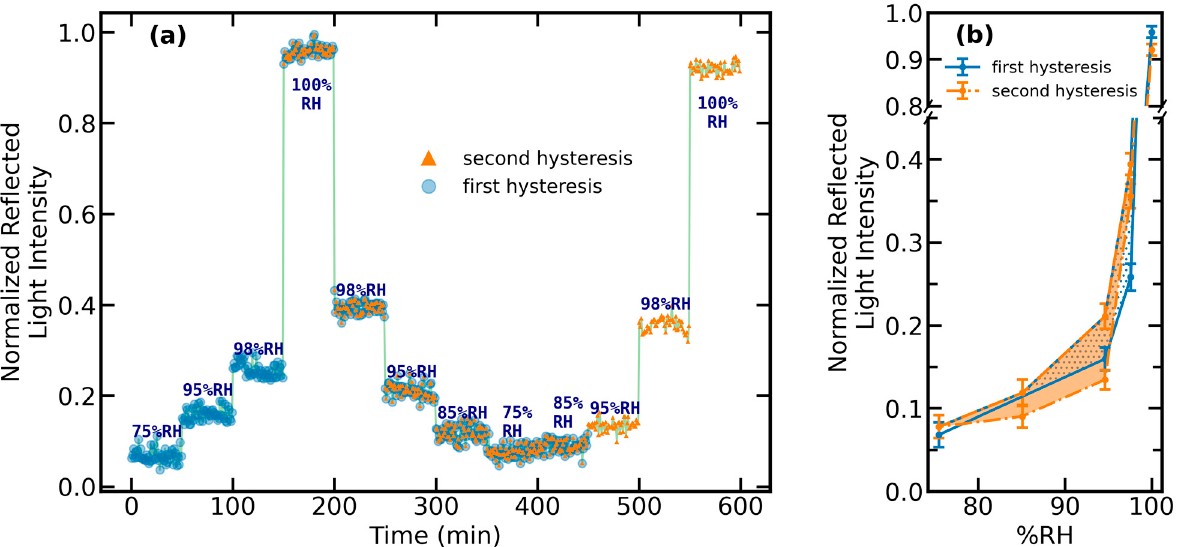
Figure 5. ( a ) Normalized reflected light intensities for different RH between 75% and 100%. The values of 75%, 85%, 95%, and 98% are rounded values from Table 1. ( b ) The two-resulting hysteresis.